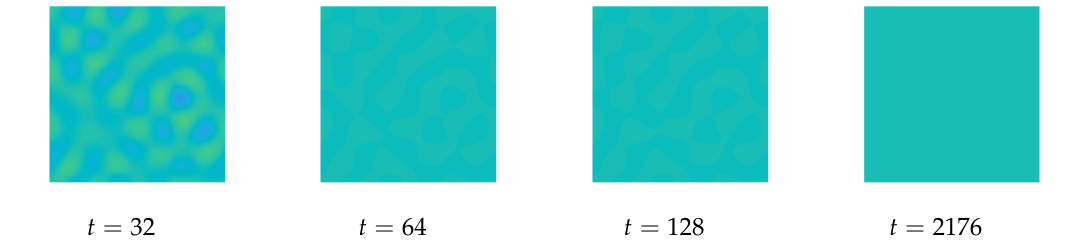
0.3710, respectively. −